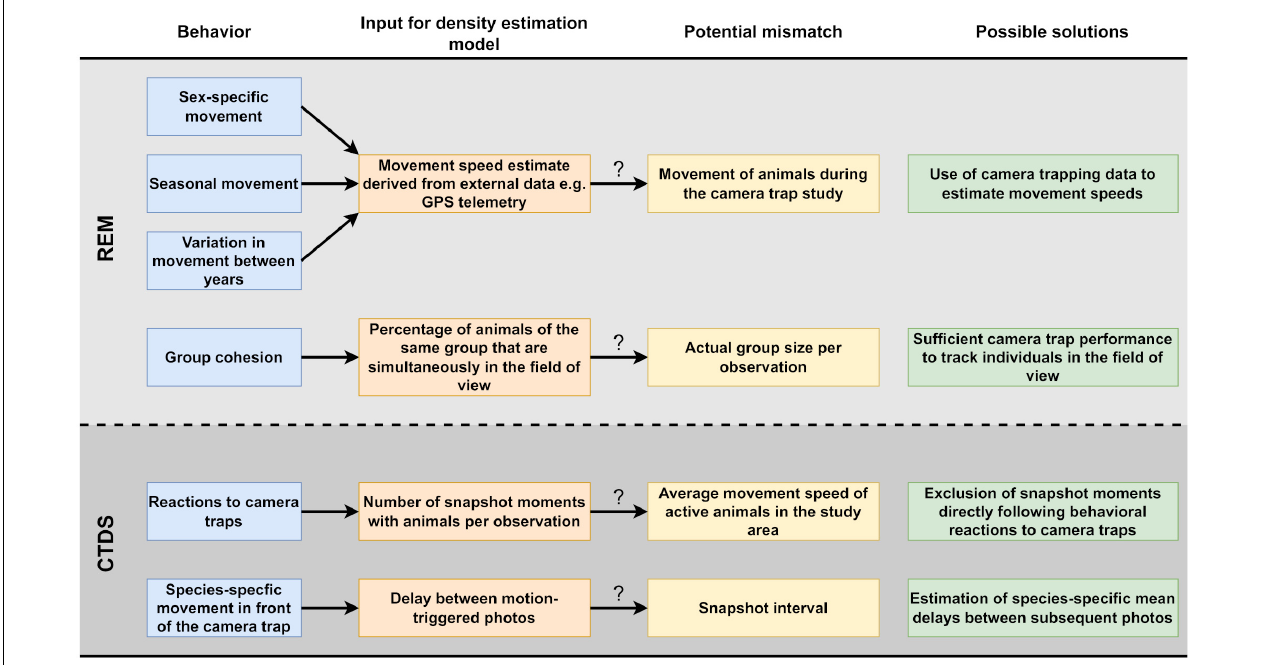
FIGURE 1 | Potential problems caused by animal behavior in the estimation of population densities of unmarked animal species using camera traps and our proposed solutions.